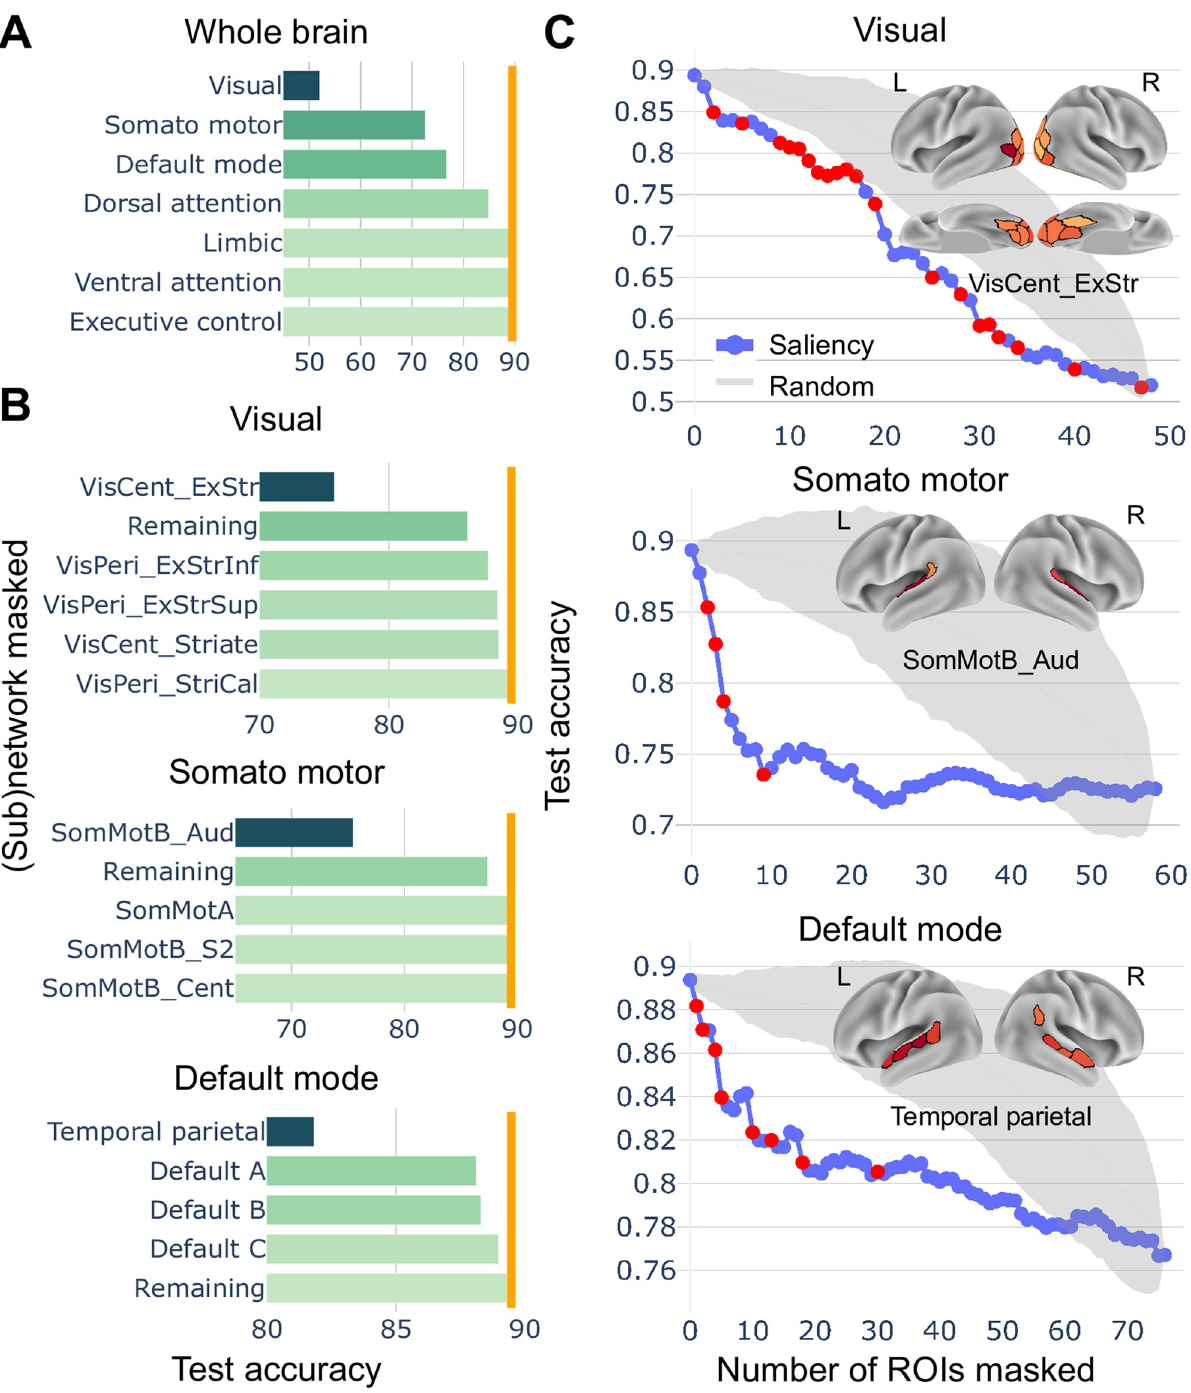
Fig 5. Lesion analysis. (A) The impact of a lesion in each of the seven standard networks is shown. The orange line shows accuracy without any lesion. (B) The impact of lesions to specific subnetworks was also evaluated, revealing greater contributions to clip classification by specific sets of brain regions. (C) Comparison of removal of regions from a given network ( visual , somato-motor , or default mode ) relative to a random set of regions from that same network. Removing regions in descending order of overall saliency (see text) impacted classification more than selecting regions without considering saliency (without replacement). For illustration, we also display the regions of the most impactful subnetworks observed in part B (red dots; also shown in the insets). The gray region shows the 95% confidence interval when the same number of regions were excluded at